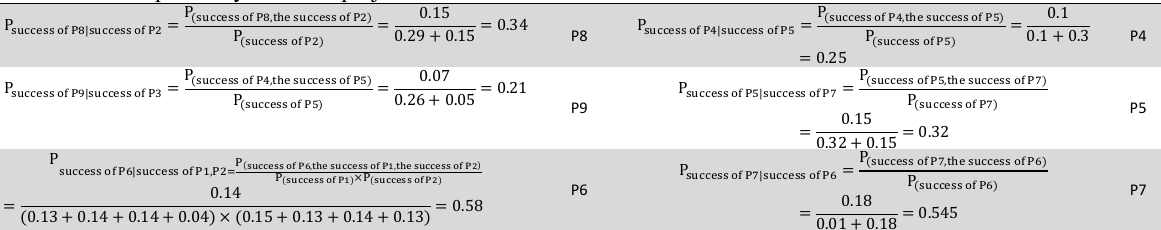
Technical interdependency scores of projects